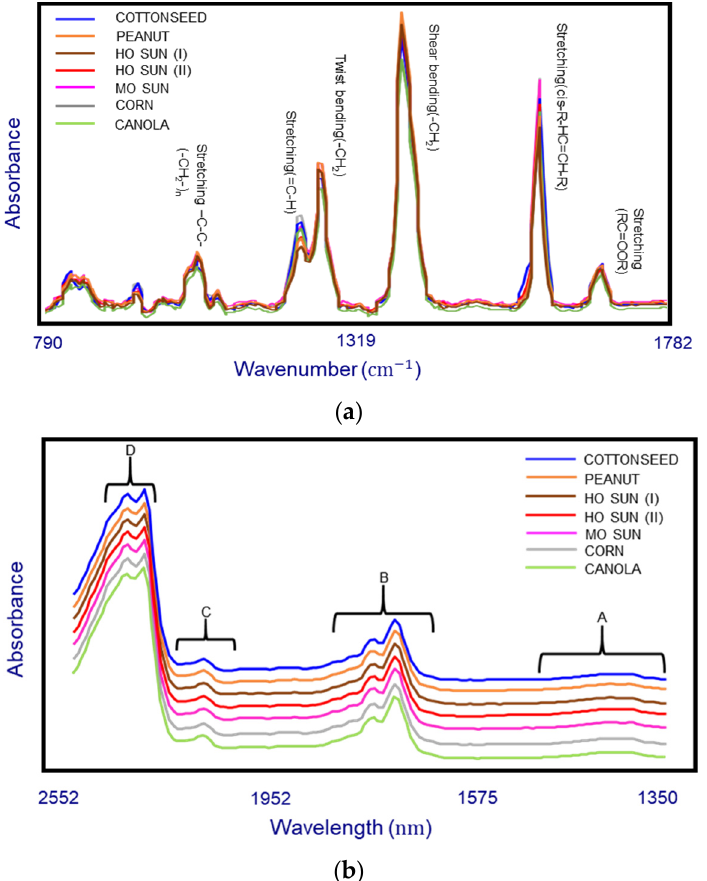
Figure 2. ( a ) Raman spectra and band assignments of some vegetable oil examples collected by a handheld Raman instrument equipped with a 1064 nm excitation laser. ( b ) Near-infrared (NIR) spectra and important absorbance regions of vegetable oils collected by a miniature NIR sensor.